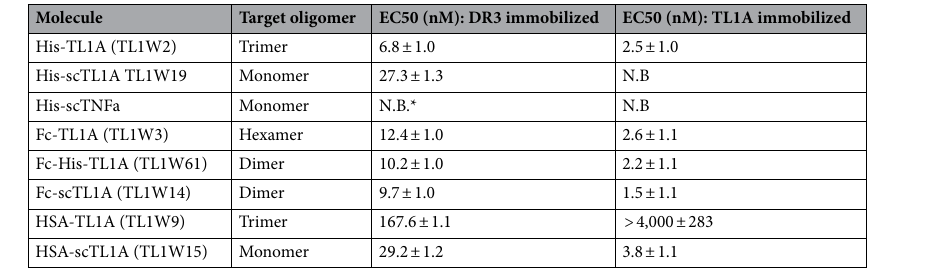
Table 2. ELISA results for TL1A constructs binding to DR3. *No binding.